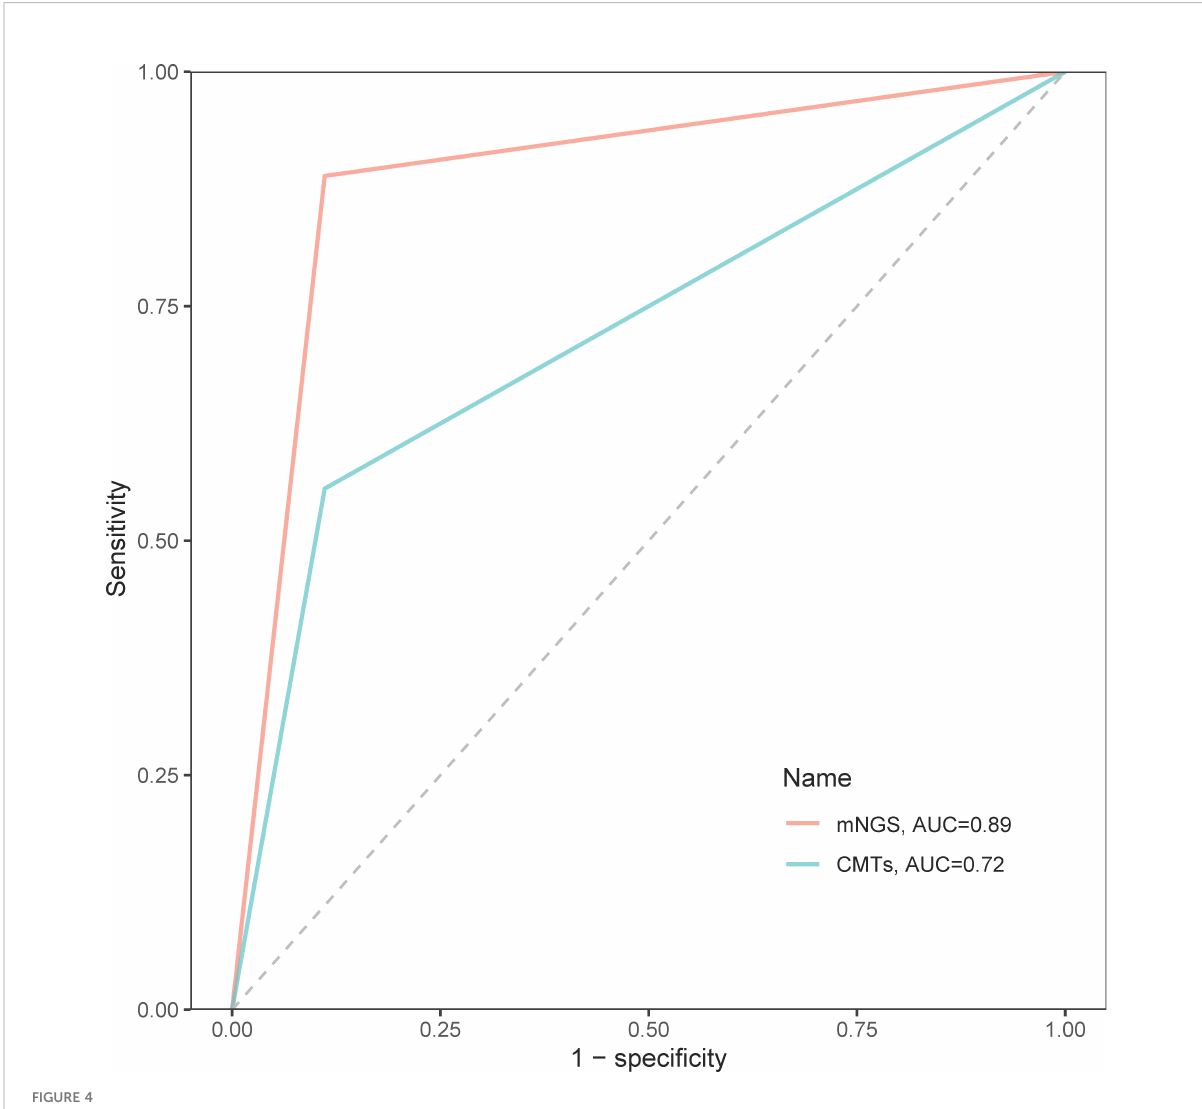
TABLE 3 Inconsistent analysis between mNGS and CMTs in the bacterial subgroup. Patient no. mNGS PCR for MTB T-spot Culture X-pert Clinical golden